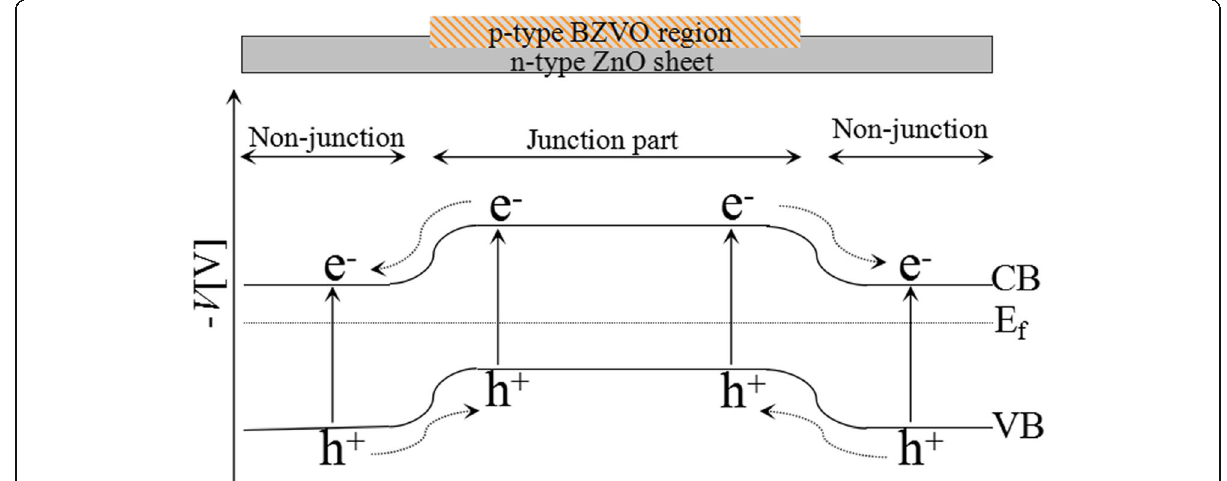
Fig. 7 Proposed band structure for partial-surface BZVO-modified ZnO